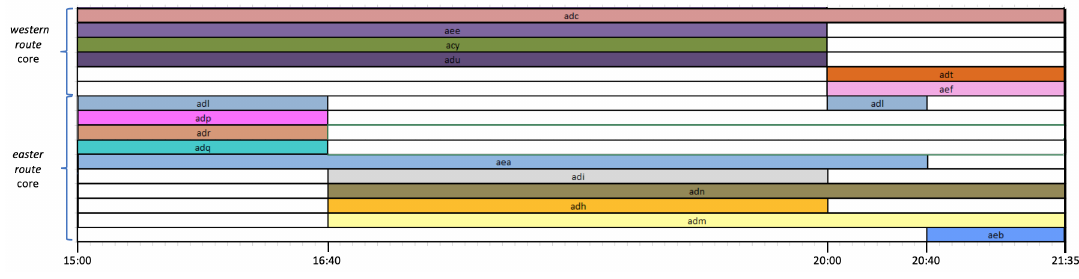
Figure 9. Sectorization after the incident of Barcelona control center (Instance 1).